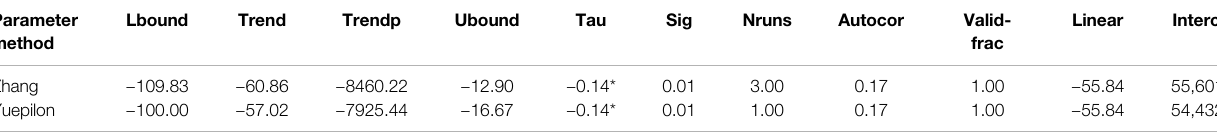
TABLE 3 | The trend analysis results by the pre-whitening approaches. Parameter method